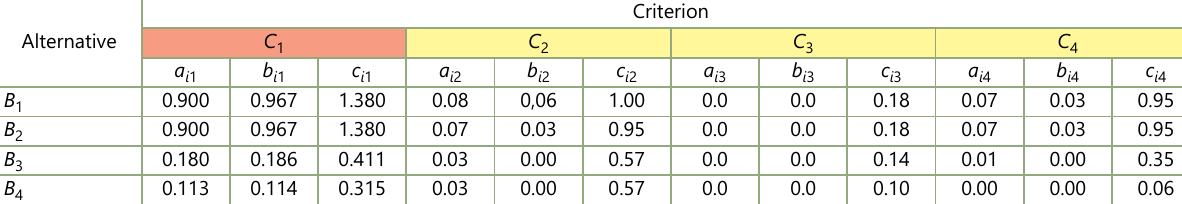
Table 15. The weighted normalized fuzzy decision matrix V G ( l ) for standard products ( l = 1) (source: own contribution)